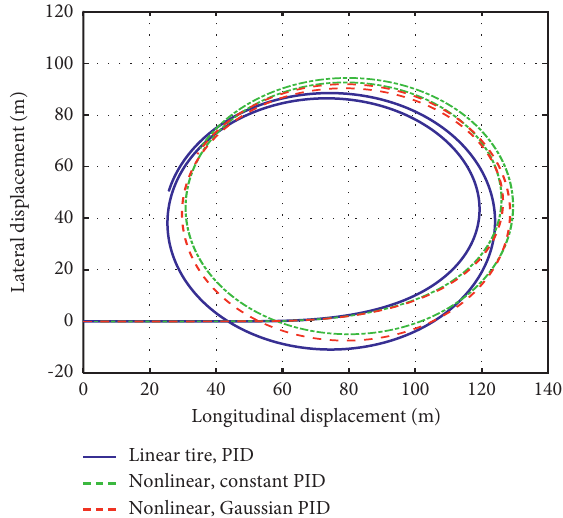
Figure 16: Comparison of vehicle routine.